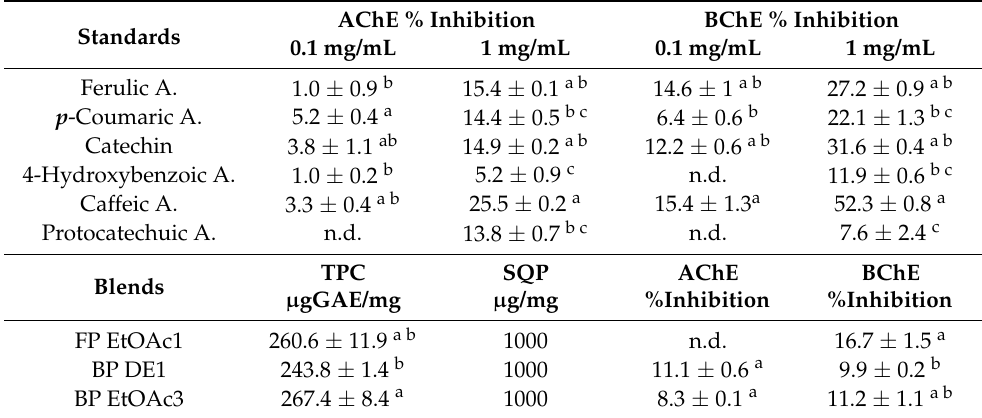
Table 4. The potential of six individual polyphenols at 0.1 and 1 mg/mL towards the inhibition (%) of acetylcholinesterase (AChE) and butyrylcholinesterase (BChE) activities. AChE % Standards